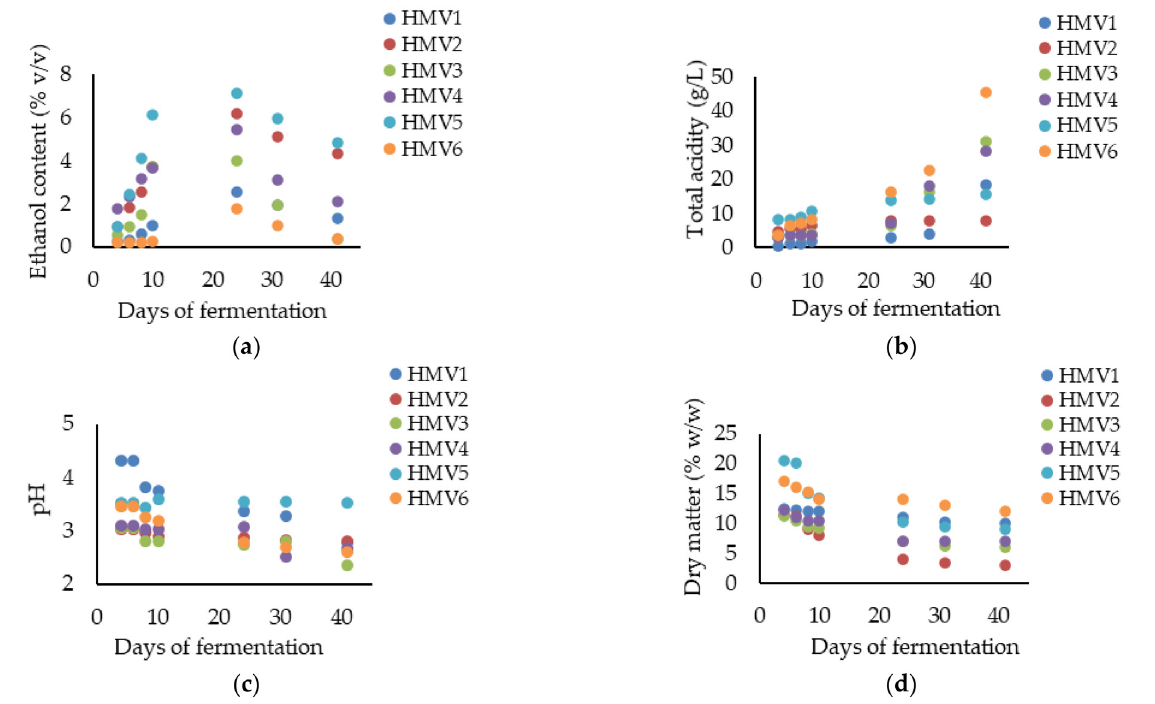
Figure 5. Variation of ( a ) ethanol content (%, v / v ), ( b ) total acidity (g/L), ( c ) pH { − log[H + ]} and ( d ) dry matter (%, w / w ) in homemade fruit vinegars (HMV) throughout fermentation time (days): apple vinegar (HMV1); raspberry vinegar (HMV2); blueberry vinegar (HMV3); blackberry vinegar (HMV4); rose hip vinegar (HMV5); persimmon vinegar (HMV6). The results were expressed as mean values and standard deviations (mean ± STDV) and calculated from two replicates of each fermentation and three analytical